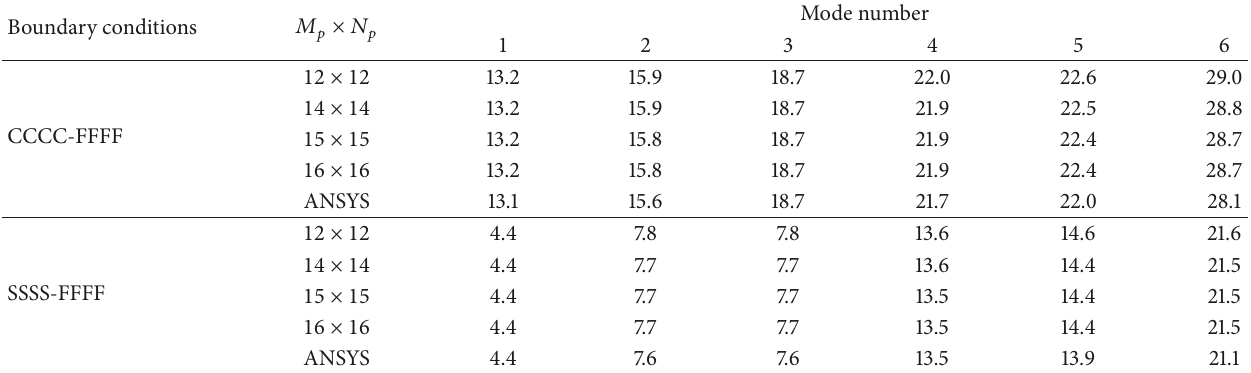
Table 1: Convergence of the first six natural frequencies (Hz) of the square plate with square opening 1.1m × 1.1m for different boundary conditions.